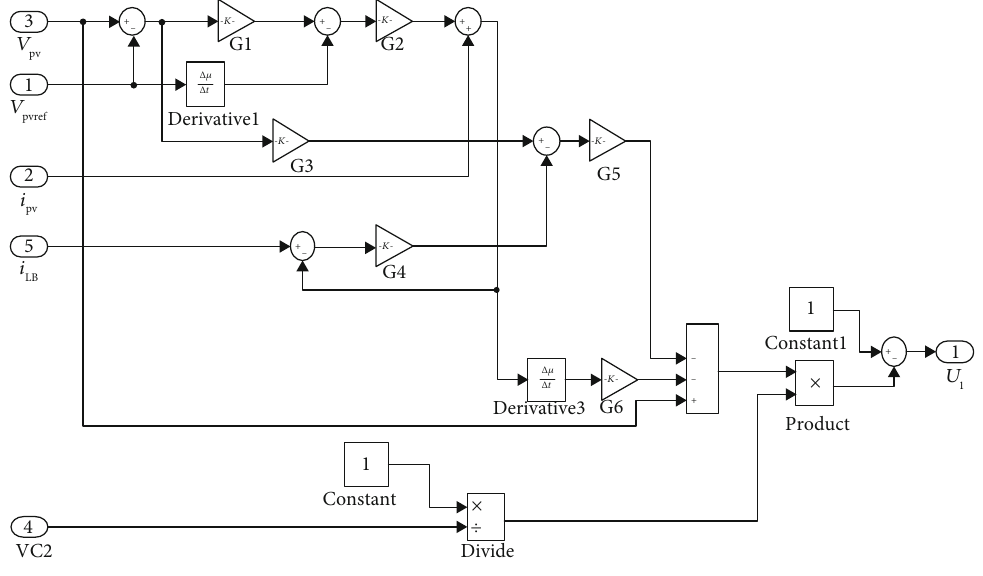
Figure 10: Internal blocs of back-stepping control 1.